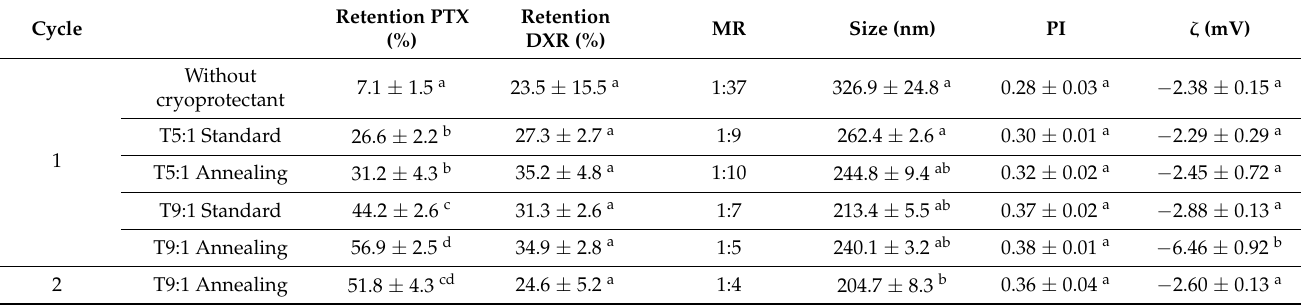
Table 5. Physicochemical characterization after freeze-drying/reconstitution of LCFL-PTX/DXR